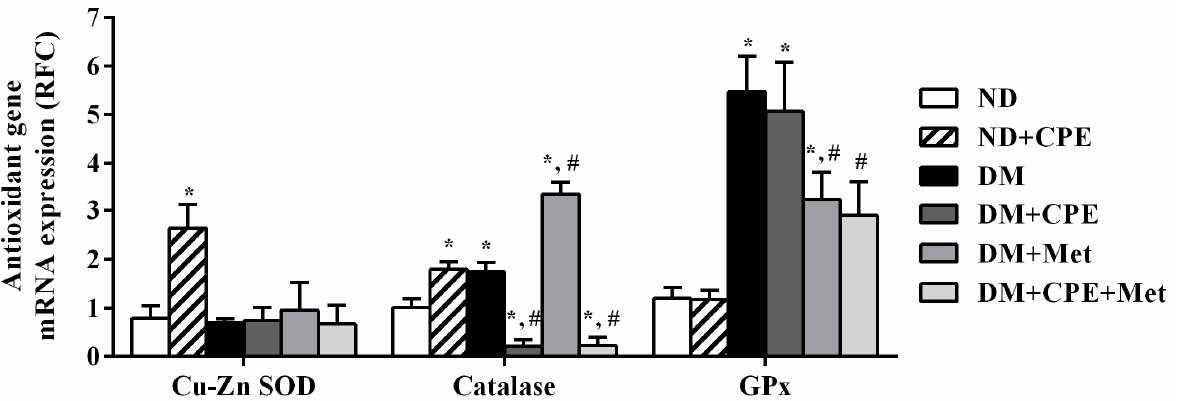
Figure 4. Effect of CPE on mRNA expression of renal antioxidant gene markers in T2D rats. Levels of Cu-Zn superoxide dismutase (Cu-Zn SOD), catalase, and glutathione peroxidase (GPx) mRNA were determined from total RNA extracted from rat renal cortical tissues using real-time quantitative PCR. The results are expressed as mean ± S.E.M and repeated in separate animals ( n = 4–5). * p < 0.05, significantly different from ND; # p < 0.05, significantly different from DM.